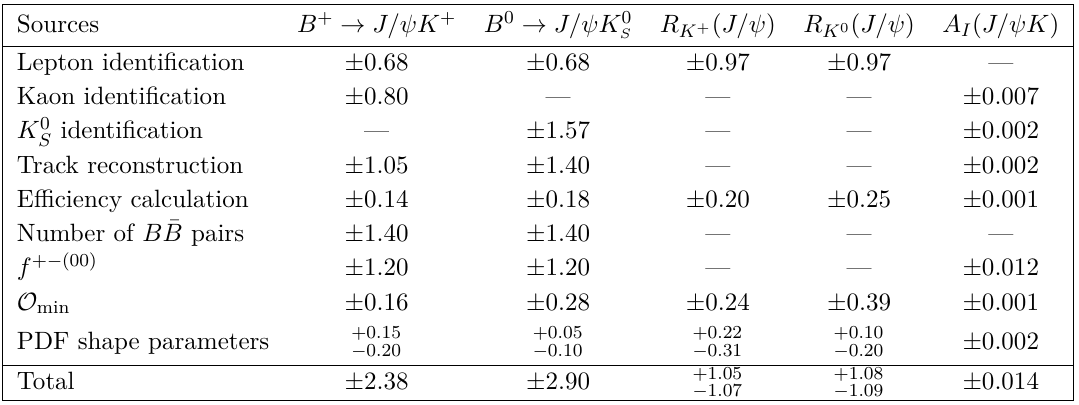
Table 4 . Relative systematic uncertainties (%) for B ( B → J/ψK ) , R K ( J/ψ ) , and absolute uncer- tainty for A I ( B → J/ψK )